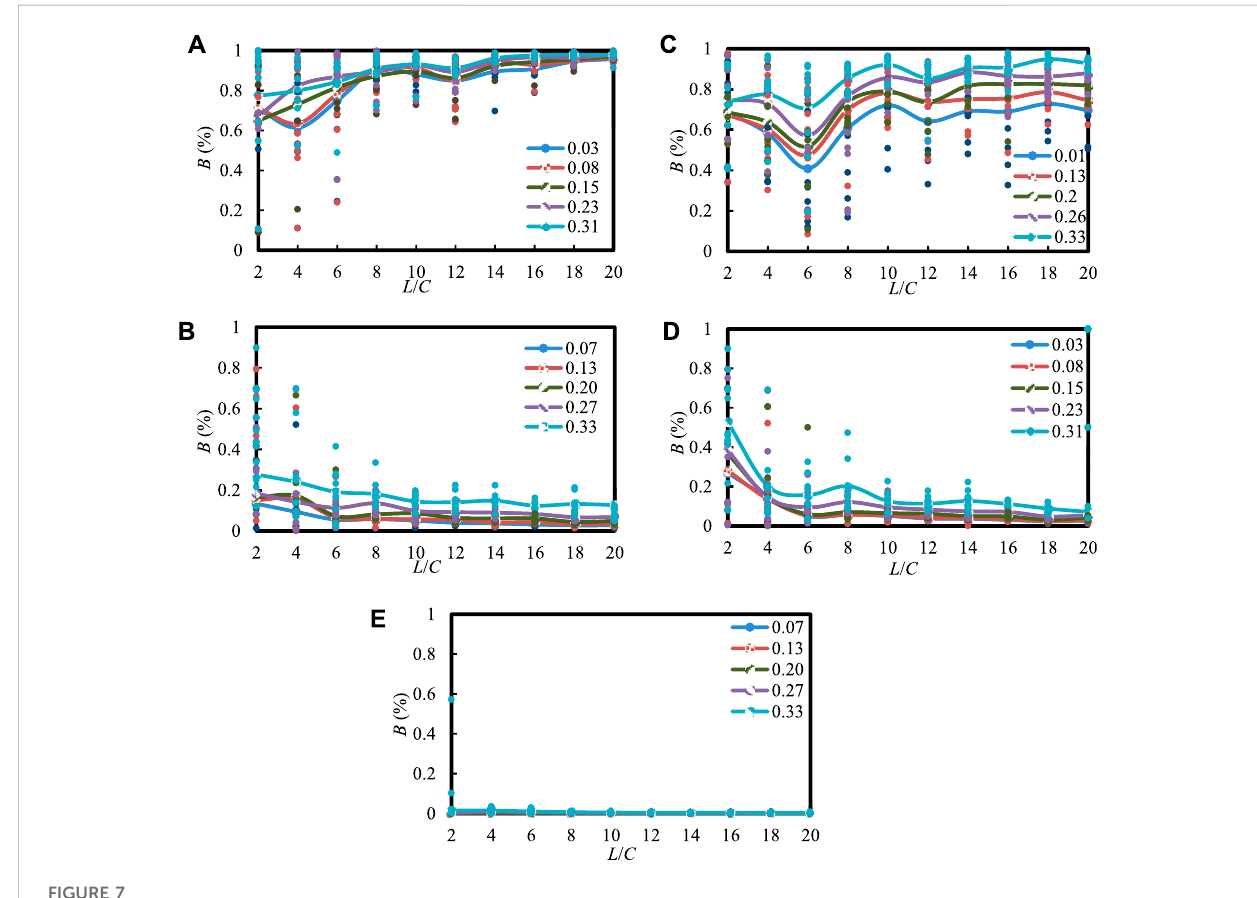
The relationships between B and the domain size of the fi ve models: models of (A – E) is I to